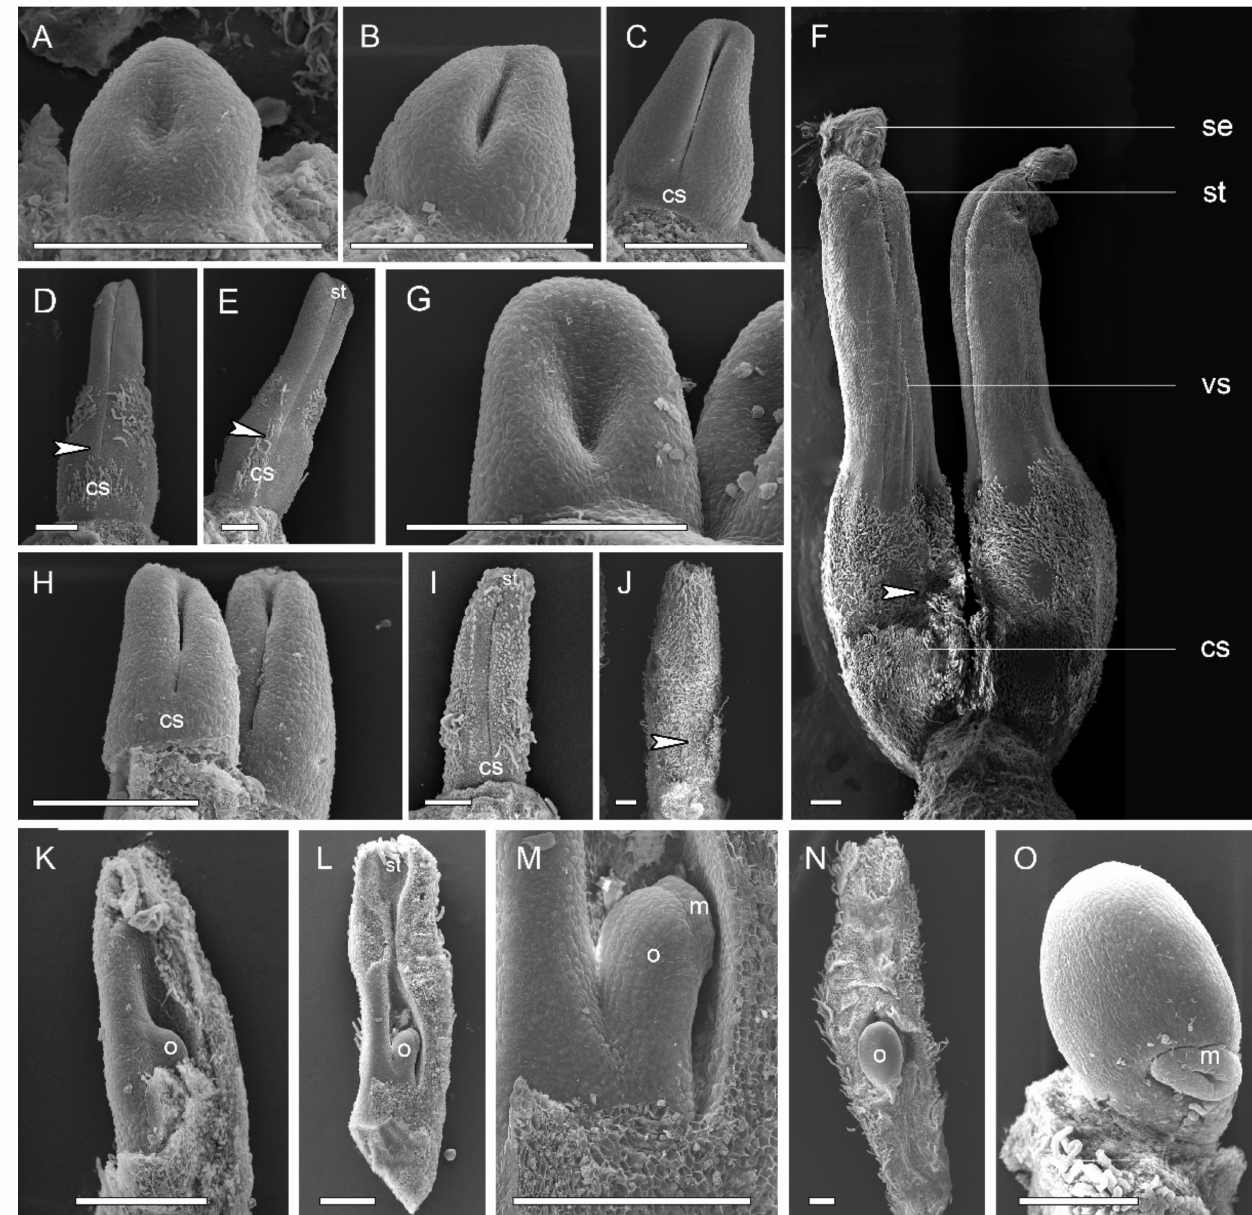
Figure 2. Carpel organogenesis in two Anaxagorea species. ( A – F ) Anaxagorea luzonensis . ( A ) Carpel primordia. ( B , C ) Carpel stipe emergence. ( D , E ) Carpel thickening and stigma formation, showing carpel stipe elongation. ( F ) Mature carpels. ( G – O ) Anaxagorea javanica shows similar carpel developmental features to changes depicted in A – F . Ventral slit end indicated by arrows. ( K ) The ovule before the integuments initiate. ( L , M ) Young ovule, with the carpel at the stage of I . ( N , O ) The ovule nearly mature. Cs, carpel stipe; m, micropyle; o, ovule; se, stigmatic exudate; st, stigma; vs, ventral slit. Scale bars = 200 µ